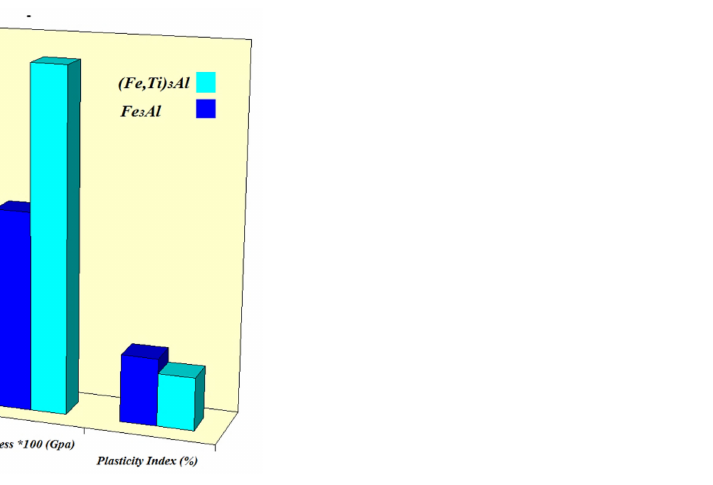
Figure 9. Mechanical properties of Fe 3 Al and (Fe,Ti) 3 Al determined using nano-indentation